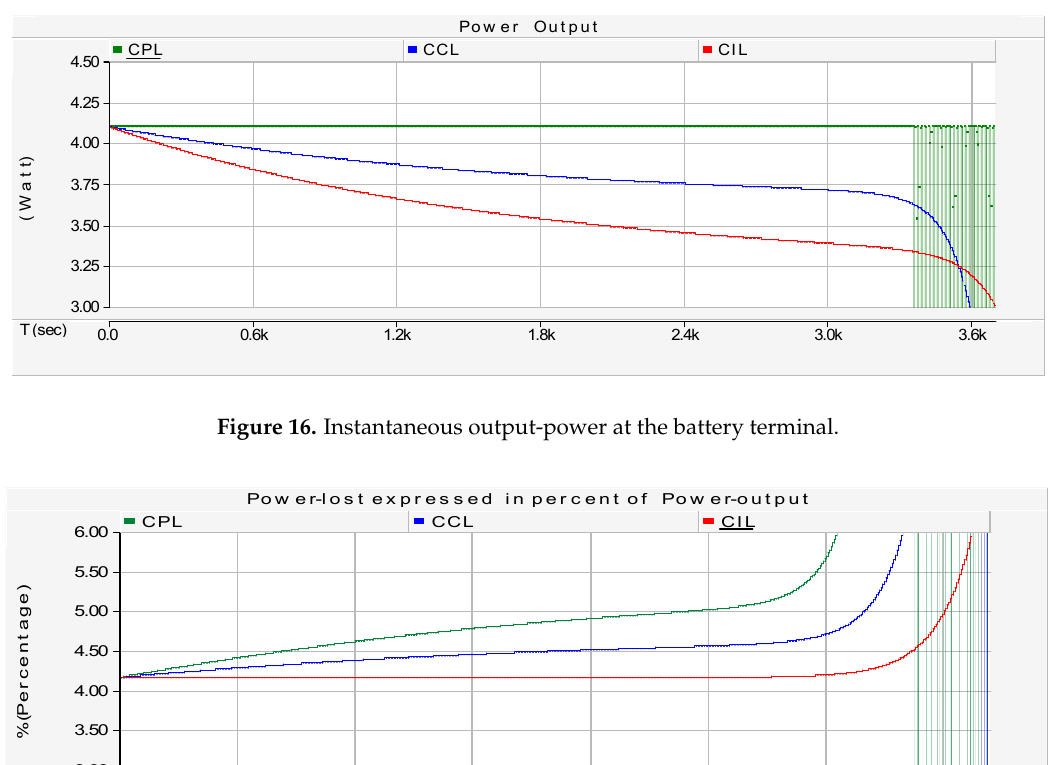
Figure 17. Power ‐ lost expressed as percent of power ‐ output.